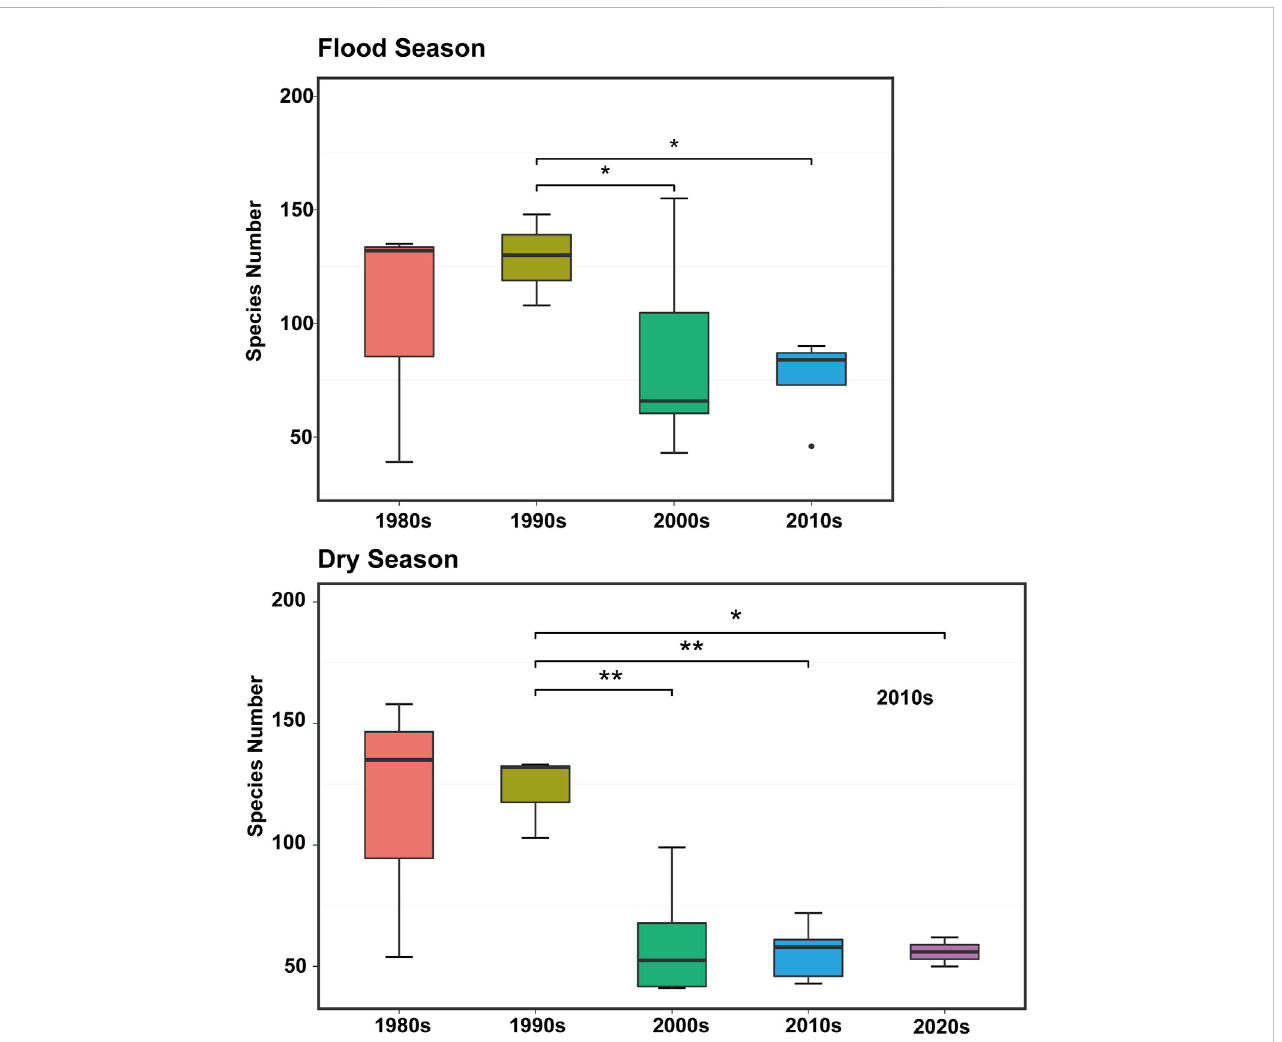
Variation characteristics of phytoplankton species number in the Pearl River Estuary during the fl ood seasons from the 1980s – 2020s. Asterisks indicate signi fi cant differences (* p < 0.05, ** p < 0.01) (Song, 1991; Dai et al., 2004; Huang et al., 2004; Liu, 2008; Dong et al., 2009; Li et al., 2010; Feng et al., 2012; Wang et al., 2013; Zhou et al., 2016; Xu et al., 2017; Xiong and Liu, 2018; Xu et al.,